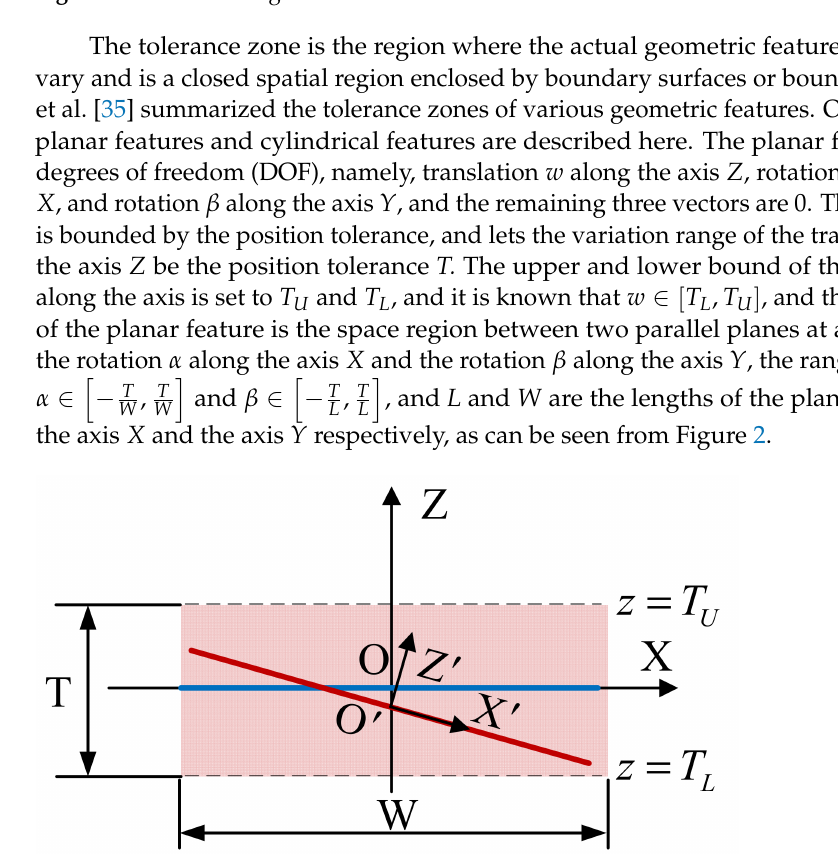
Figure 1. Schematic diagram of the torsor model.